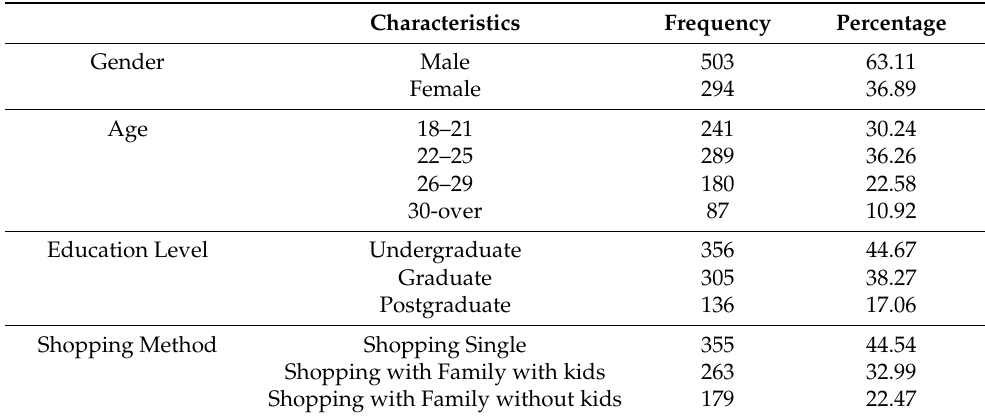
Table 2. Respondent profile.